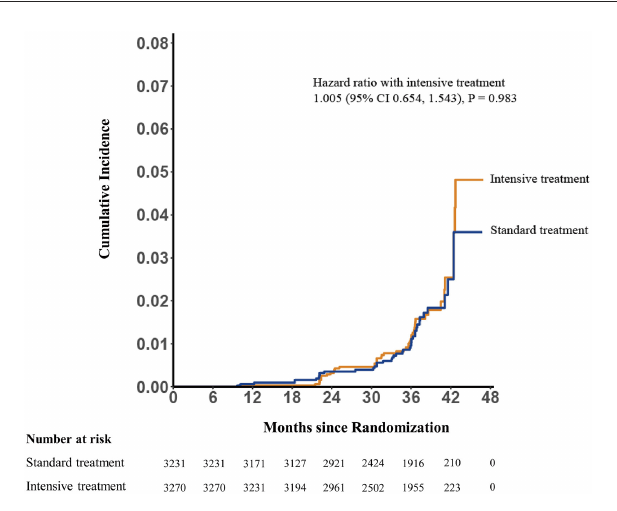
FIGURE3 Potential cognitive impairment by treatment group. Hazard ratio 1.005; 95% CI, 0.654, 1.543, p = 0.983 for group comparison of